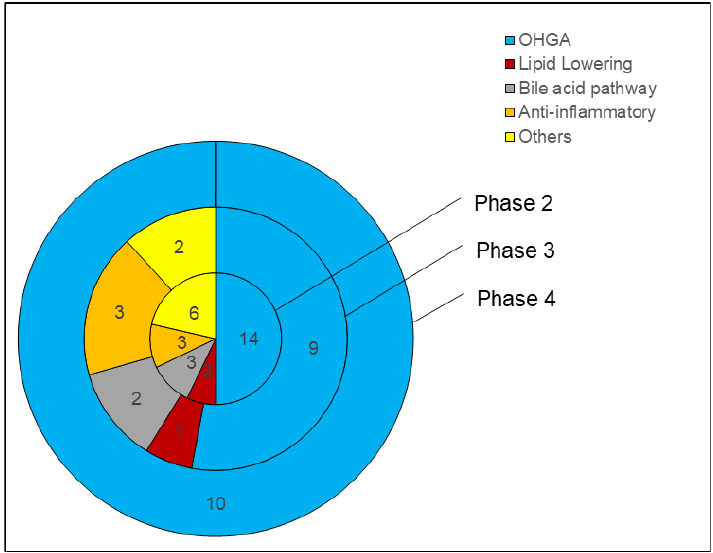
Figure 1. The landscape of NAFLD clinical trials is evaluated in this study. Furthermore, OHGAs included 10 drugs, with 7 at or having completed phase 3 trials and 1 having a terminated phase 3 trial (Table 5). Lipid-lowering drugs included 4 drugs, with 1 in phase 3 trials. Bile pathway drugs included 3 drugs, with 1 in phase 3 trials. Anti- inflammatory drugs included 3 drugs, with 2 having terminated phase 3 trials. There were 2 other drugs at or having completed phase 3 trials. Trials also included 4 combination drugs and 11 repurposed drugs. Beyond pharmaceuticals, 5 nutraceuticals and gut micro- biota were also considered for NAFLD management. Table 5. Clinical trials on oral hypoglycemic agents were evaluated. Oral Hypoglycemic Agents